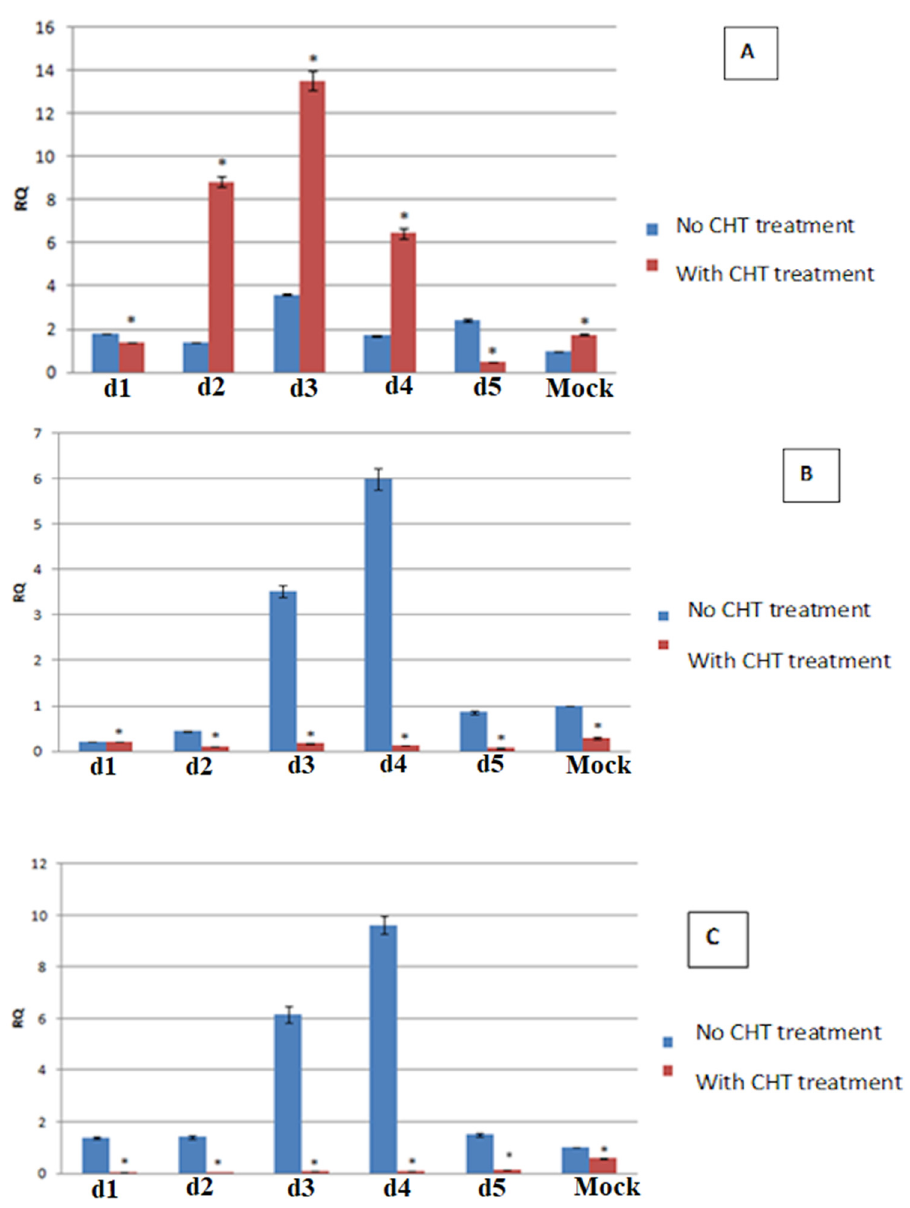
Figure 5. Expression analysis of three cellular genes in the E-11 cell line treated with 0.3% Chitosan for different time periods (d, days post challenge). ( A ) Relative qualitification (RQ) values for the CCR3 gene transcript, ( B ) Relative qualitification (RQ) values for the TNF- α gene transcript and ( C ) Relative qualitification (RQ) values for the Il-10 gene transcript. Cultures shown in presence of chitosan (CHT) treatment (column in red with * sign) and without chitosan (CHT) treatment (column in blue). Fold expression was calculated as 2 −∆∆ Ct . Control group (0 h post challenge) was taken as the calibrator.